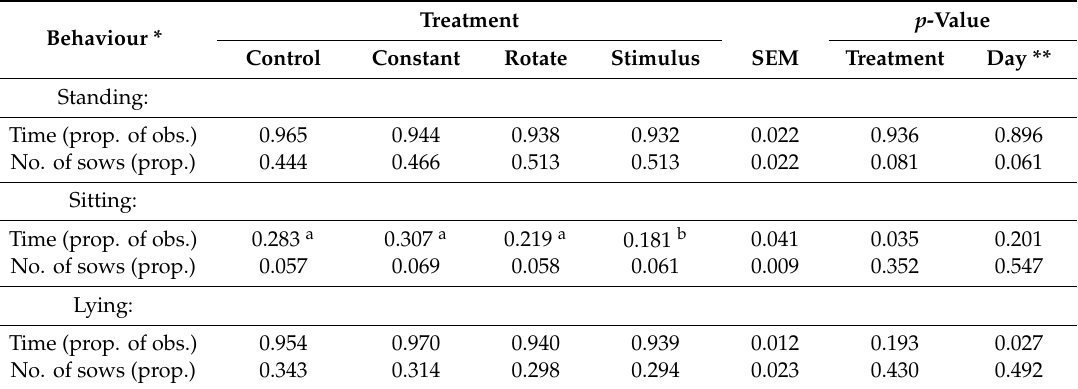
Table 3. Effects of enrichment treatment and day of observation on the postures of sows observed in photo scans*. LS Means of duration (proportion of observations) and number of sows in each posture (proportion of sows).